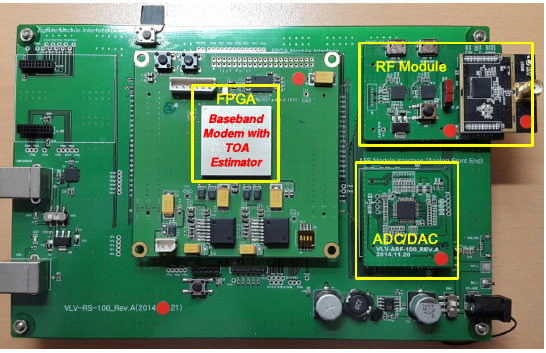
Figure 9. Experimental platform. FPGA: field-programmable gate array; ADC/DAC: analog-to-digital converter/digital-to-analog converter.